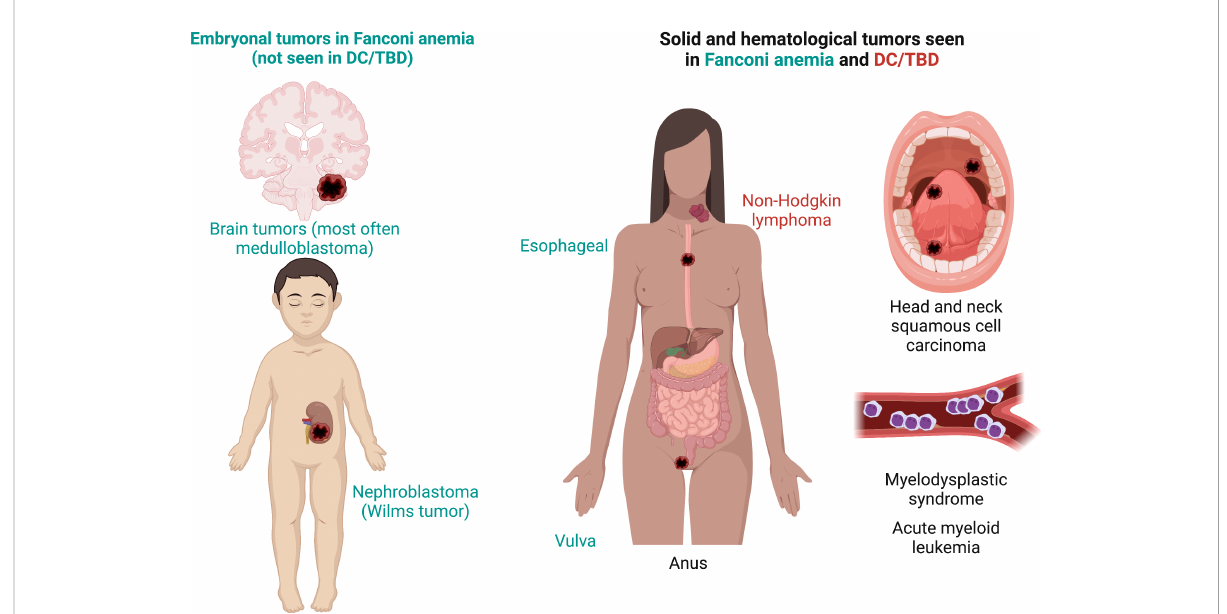
FIGURE 7 Fanconi anemia and DC/TBD share a common spectrum of cancer. SCCs may be found in gums, tongue, palate, or any other mucosal surface in the mouth; SCCs can also be found elsewhere in the gastrointestinal tract particularly in the anus and for patients with FA in the esophagus. The hematologic cancer phenotype consisting of myelodysplastic syndrome and acute myeloid leukemia is shared by both disorders. In patients with DC/TBD, non-Hodgkin lymphoma is added to the oncological spectrum. Gynecologic SCC is a distinctive feature of FA. Also, a subgroup of patients with FA with FANCD1/BRCA2 and FANCN/PALB2 genotypes have been associated with the development of embryonal tumors (Wilms tumor, neuroblastoma, and brain tumors [most often medulloblastomas]) and acute myeloid leukemia at an early age. Features exclusive to FA are in green, those exclusive to DC/TBD are in red, and those shared by both disorders are in black. DC/TBD, dyskeratosis congenita/ telomere biology disorders; FA, Fanconi anemia; SCCs, squamous cell